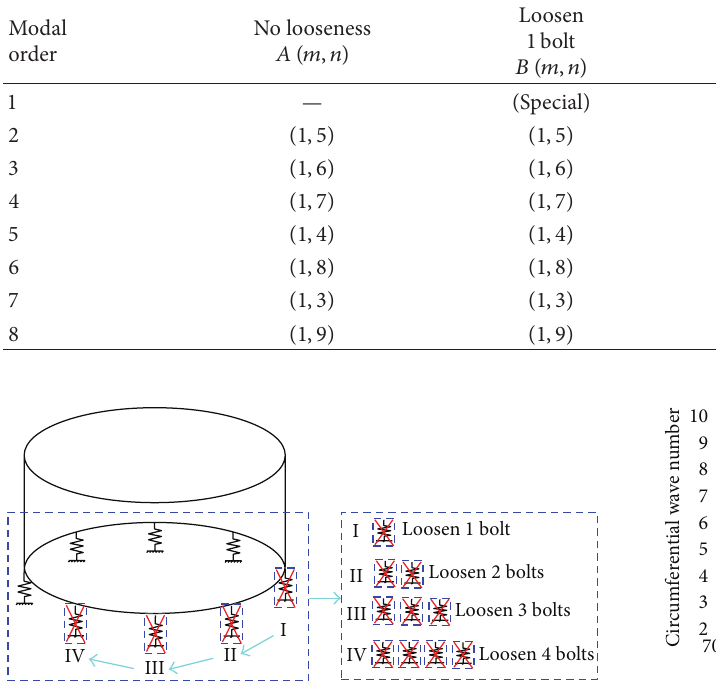
Figure 3: Schematic of bolt loosening sequence under BLB with different looseness numbers.